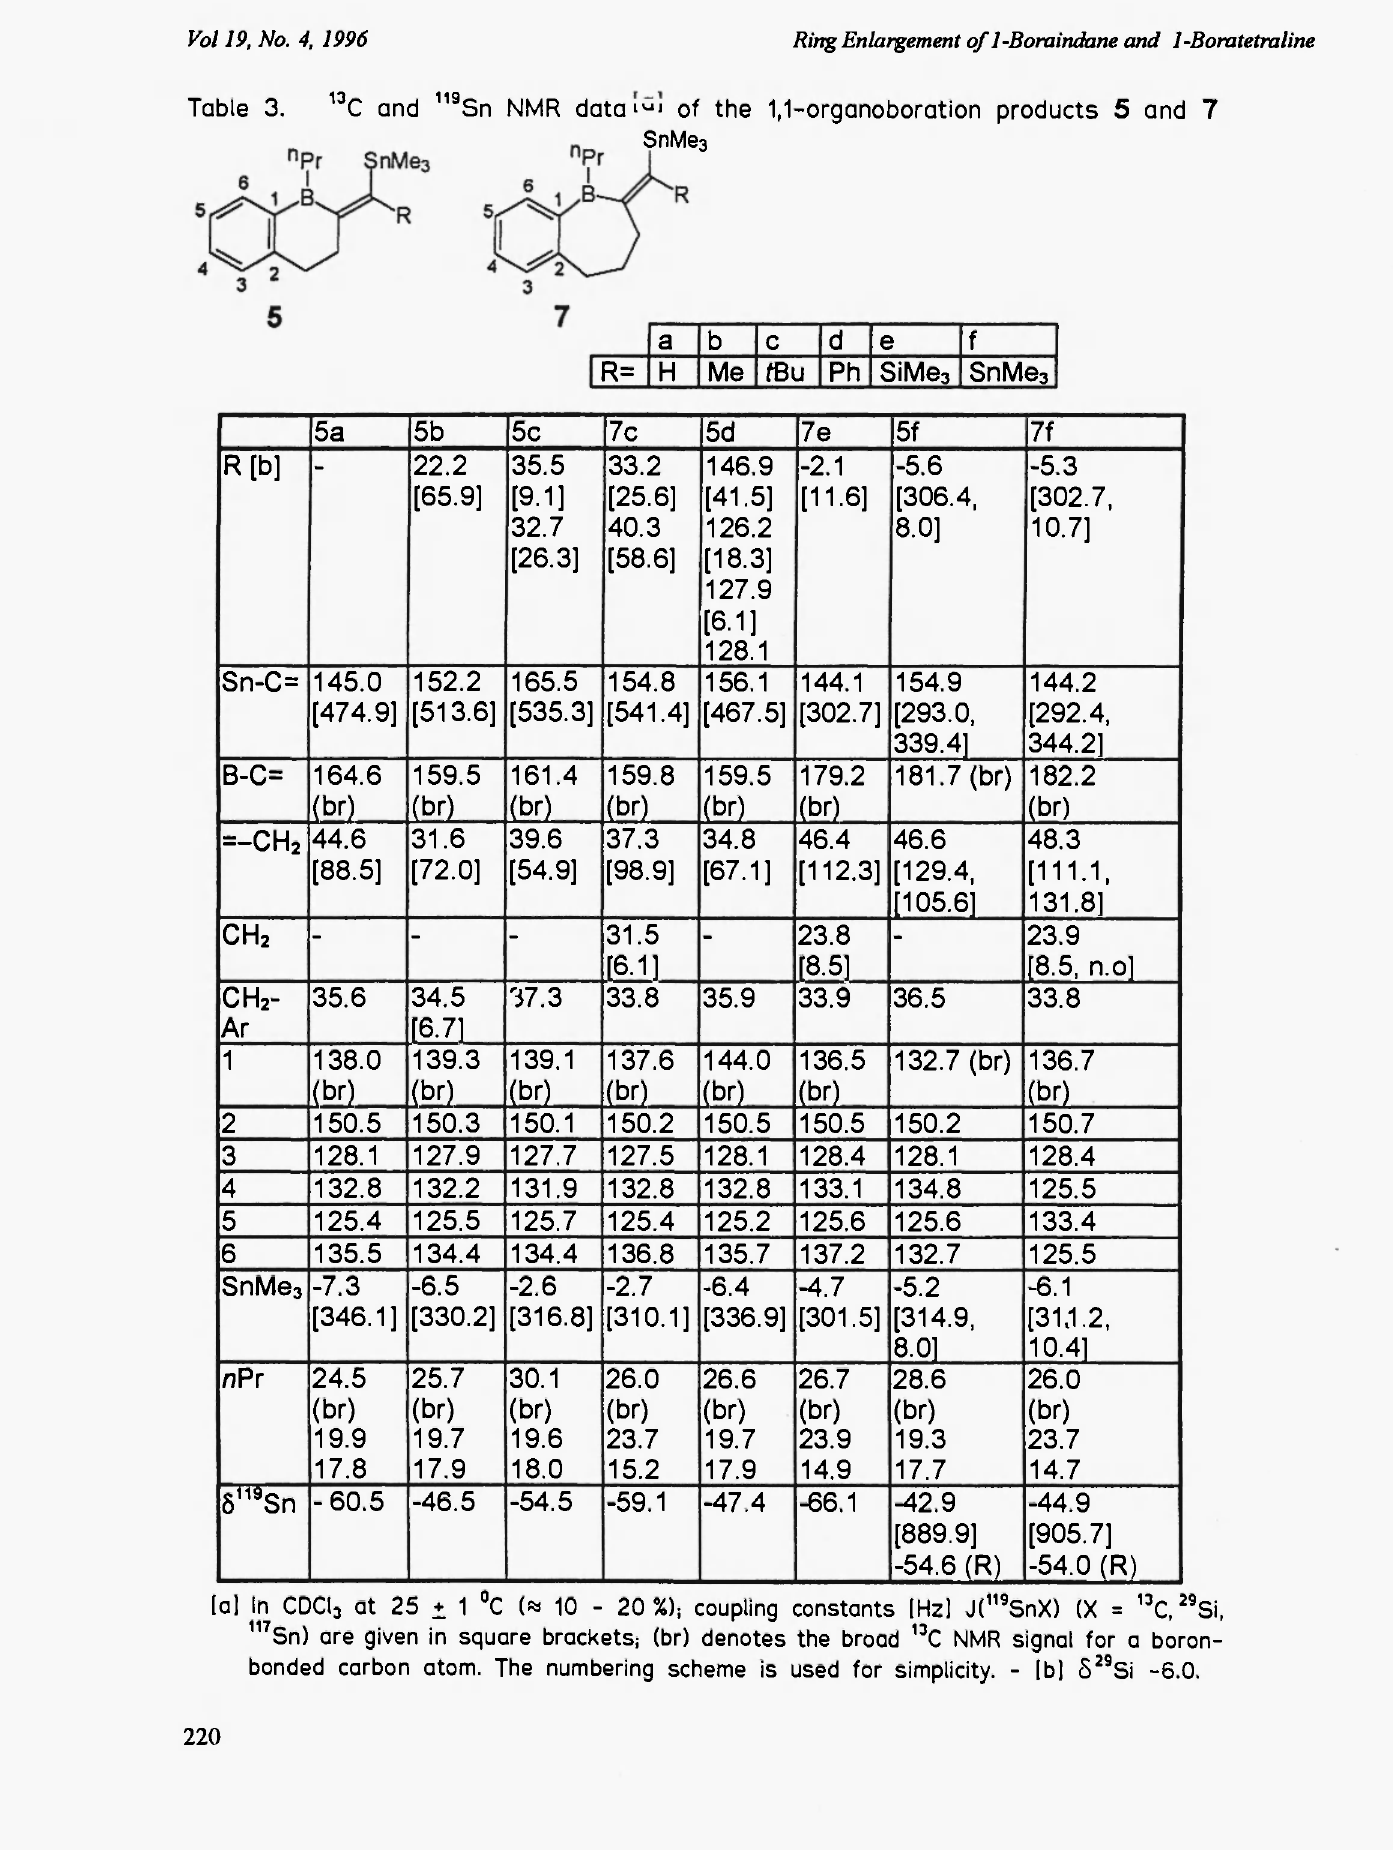
13 C and 119 Sn NMR data of the 1,1-organoboration products 5 and 7